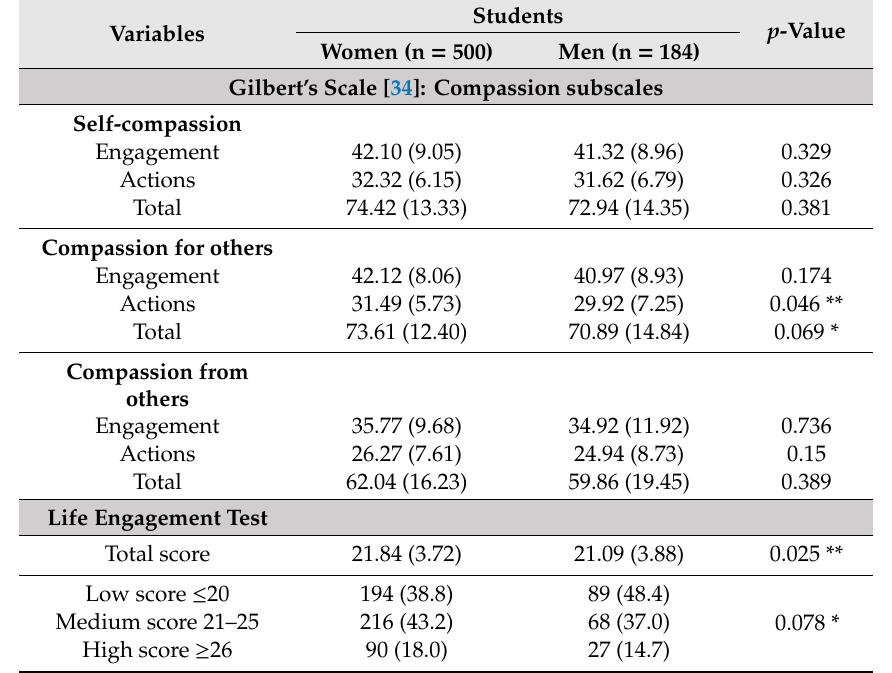
Table 5. Gilbert’s Scale and the Life Engagement Test by gender among the students (n = 684).